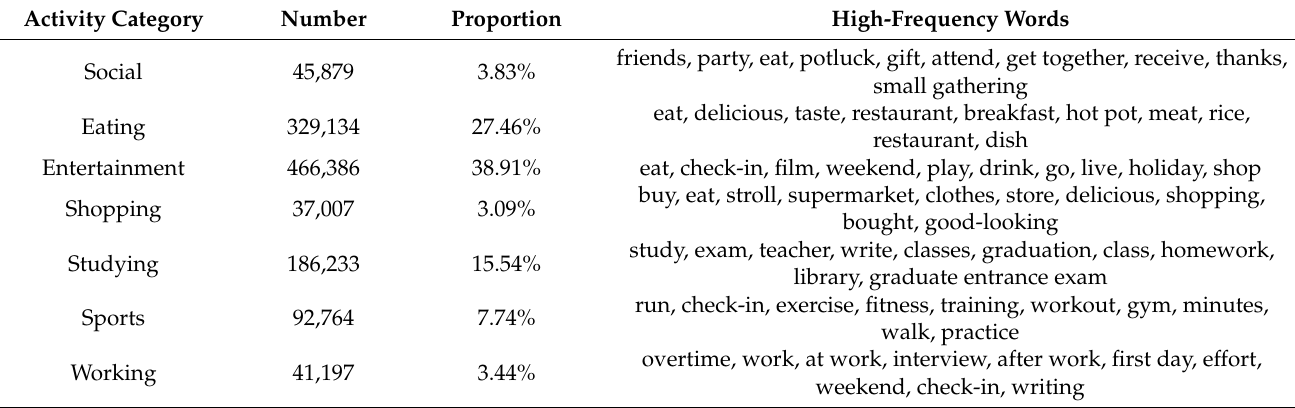
Table 4. Numbers of activity categories and high-frequency words.